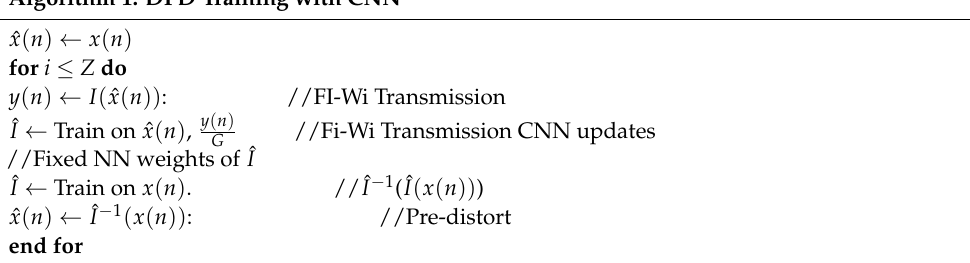
Algorithm 1: DPD Training with